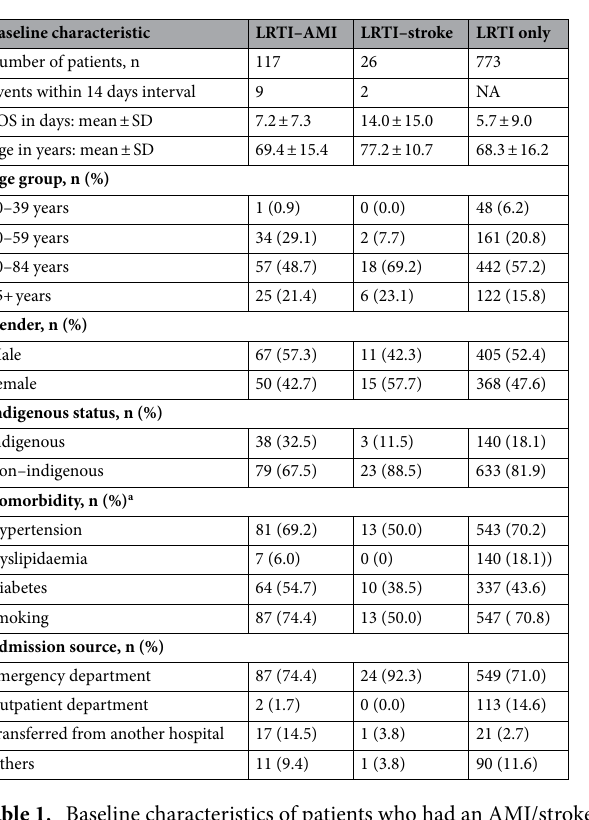
Table 1. Baseline characteristics of patients who had an AMI/stroke during 2-year period associated with LRTI exposure at the first event. LOS Length of hospital stay. a Percentages of presence of comorbidity vs. absence of comorbidity.